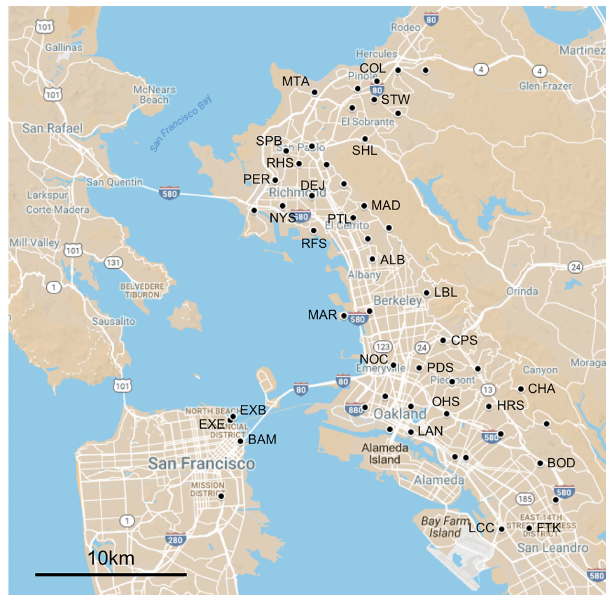
Figure 1. Map of BEACO 2 N node locations (black dots). Nodes used in this study are labeled. Map data ©2017